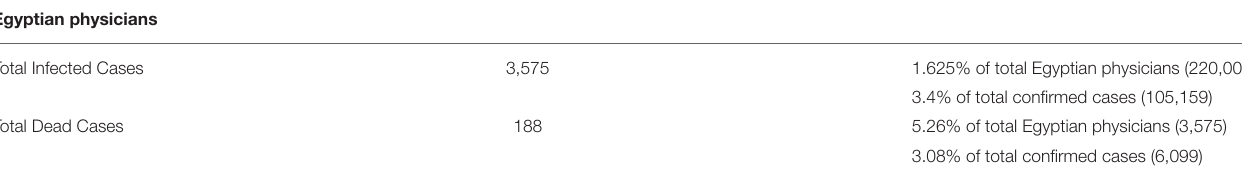
TABLE 4 | A total of Egyptian physicians who had contracted or died from COVID-19 infections by mid-October 2020.